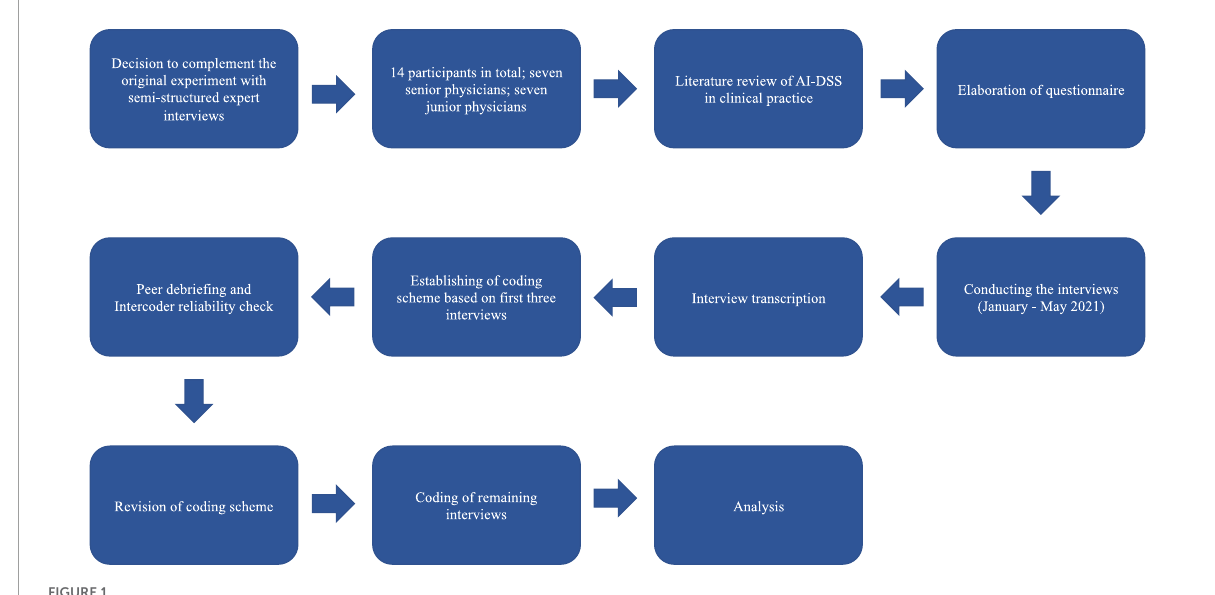
FIGURE1 Process model of the survey according to Qualitative Content Analysis by Philipp Mayring